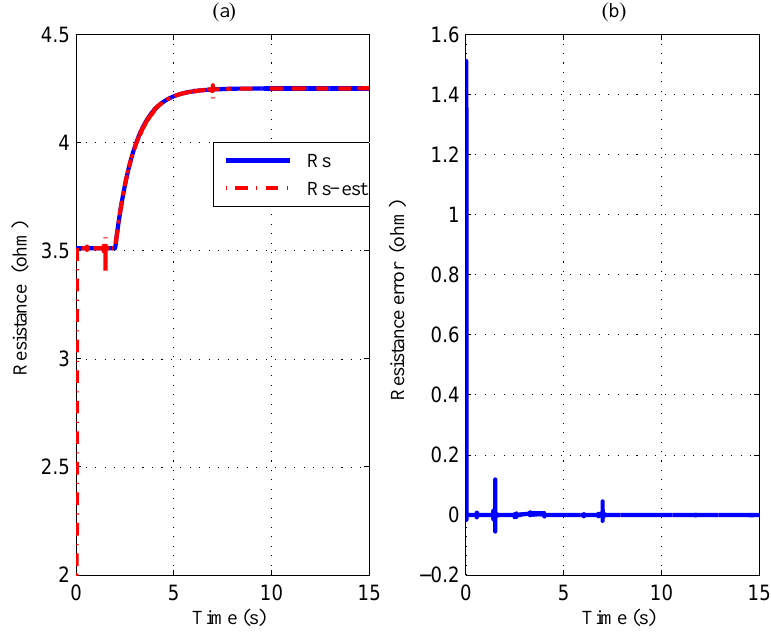
Figure 10. Robustness w.r.t. +30% R s : ( a ) estimated and real resistance; and ( b ) estimation